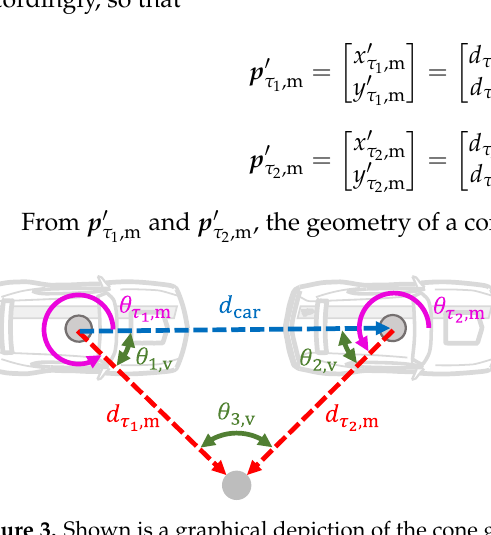
Figure 3. Shown is a graphical depiction of the cone geometry used for the velocity calculation from two LiDAR measurements that point to the same